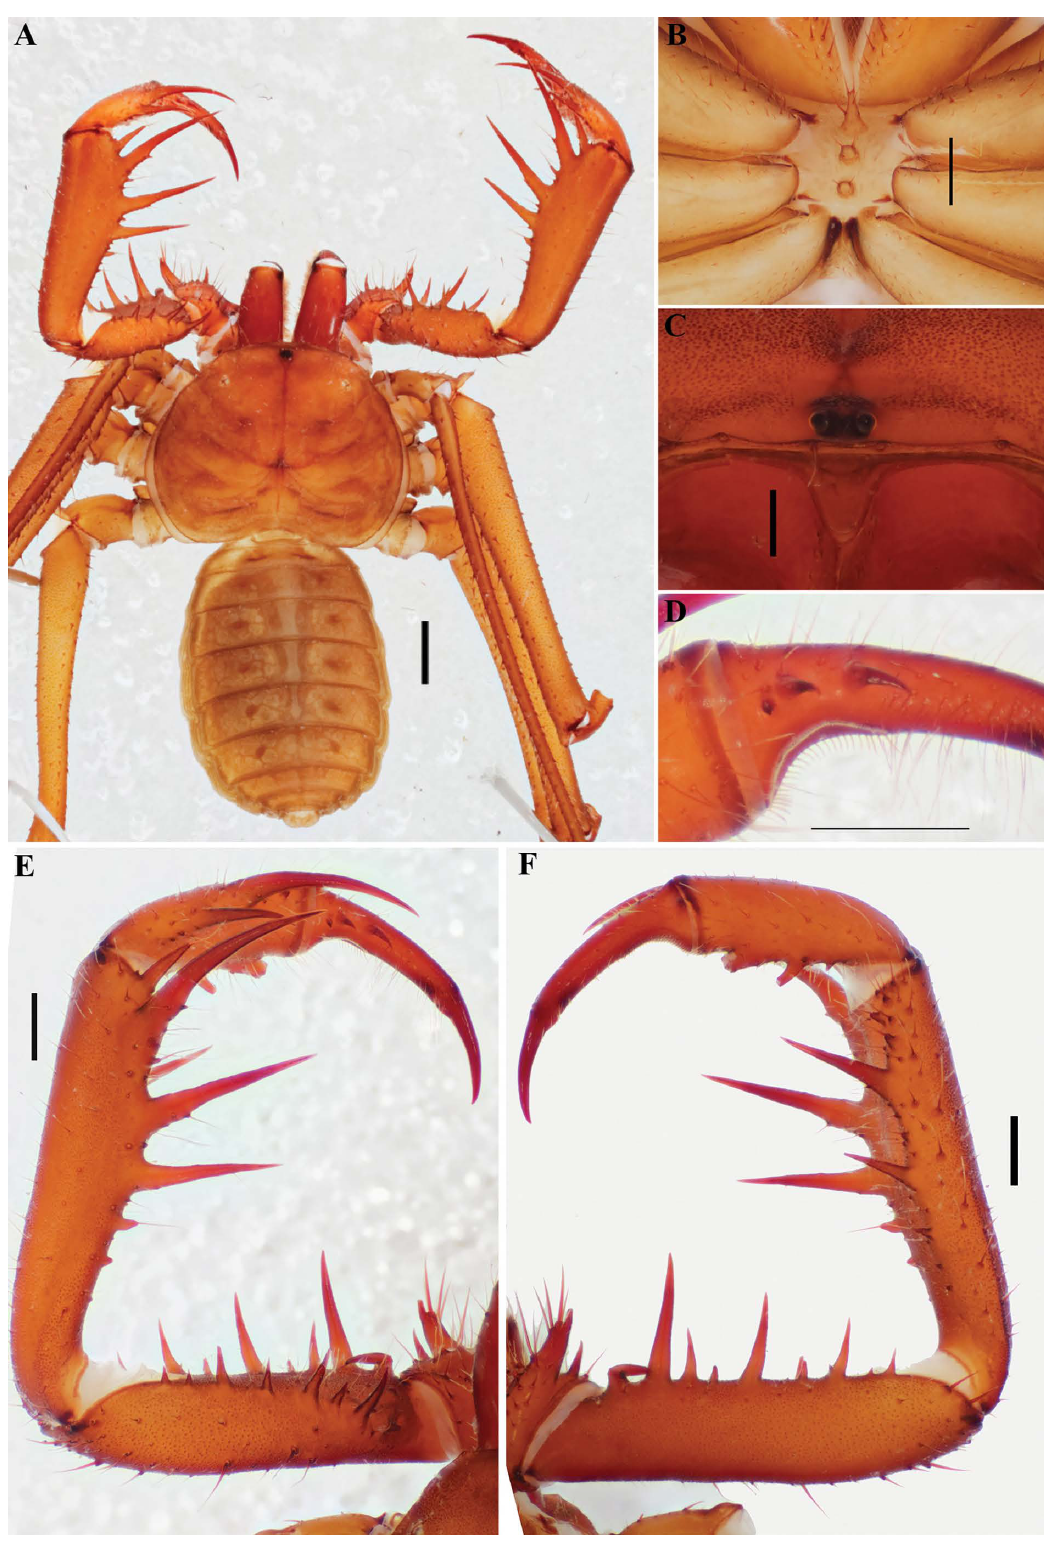
Fig. 57. Charinus diamantinus sp. nov. (MNRJ 9299), ♀, general morphology. A . Habitus, dorsal view. B . Sternum, ventral view. C . Frontal process. D . Pedipalp tarsus, frontal view. E . Pedipalp, dorsal view. F . Pedipalp, ventral view. Scale bars: A–B, D–F = 1 mm; C =